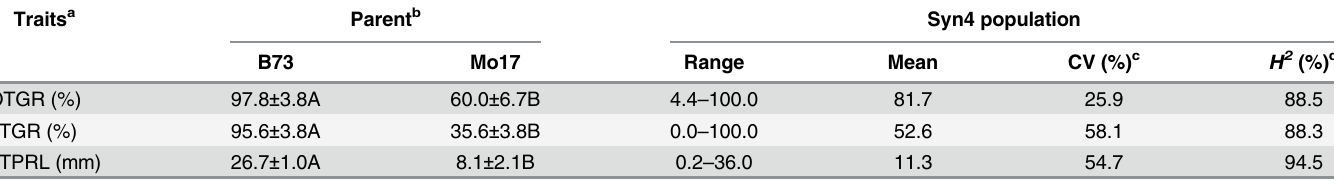
Table 1. Germination related traits of B73, Mo17 and Syn4 population and their heritabilities under low and optimal temperature conditions. Traits